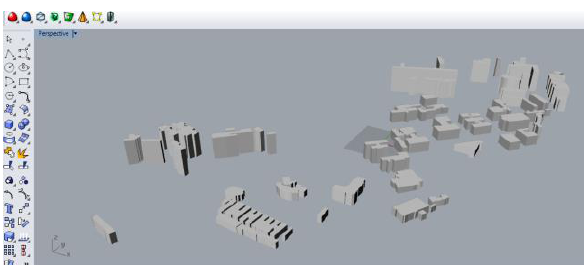
Figure 15: Geometric import in Rhinoceros using the Meerkat plugin